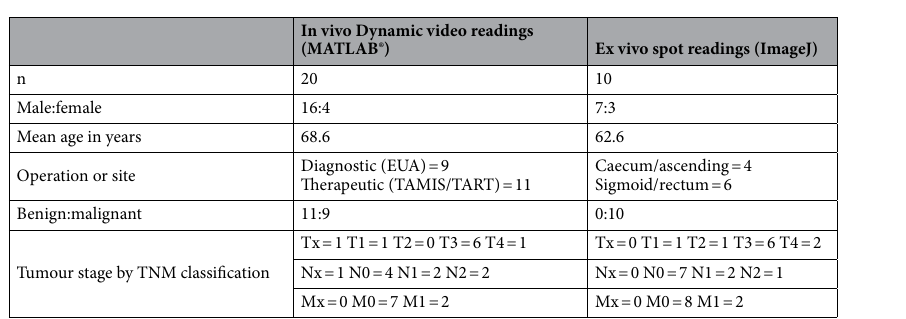
Table 1. Patient and case demographics overall and by analytic methodology. Dynamic intensity readings were made by the automated Fluorescence Tracker App. EUA, TAMIS and TART respectively denote Examination under Anaesthesia, Transanal Minimally Invasive Surgery and Transanal Resection of Tumour. In addition, two additional patients with colorectal cancer had their specimens assessed specifically to elucidate the photobleaching impact of continuous illumination over the time-period of the dynamic in-situ recordings (see Figure six).